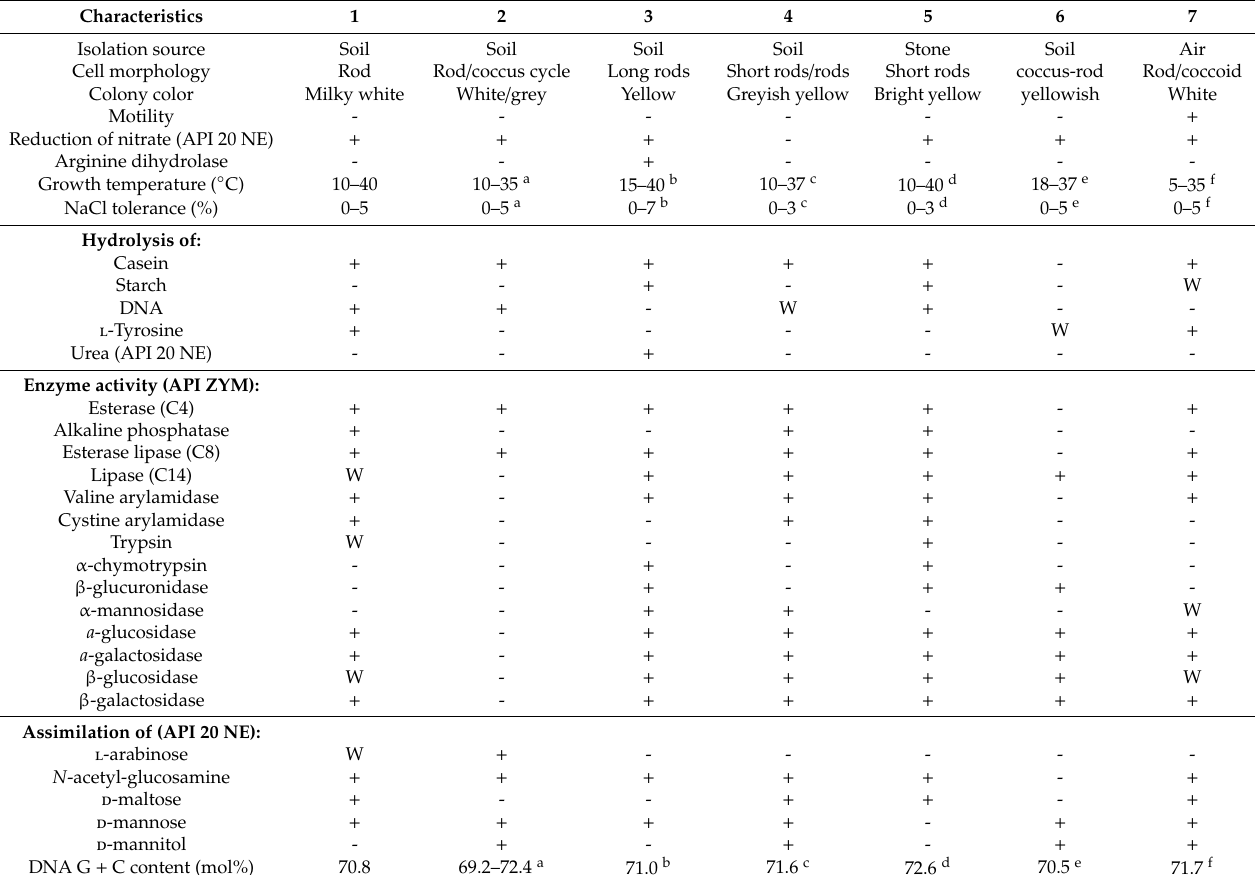
Table 1. Di ff erential characteristics of Terrabacter humi MAHUQ-38 T and phylogenetically closely related Terrabacter species. Strains: 1, T. humi MAHUQ-38 T ; 2, T. tumescens KACC 20535 T ; 3, T. terrae KACC 11642 T ; 4, T. terrigena KCTC 19602 T ; 5, T. lapilli LR-26 T ; 6, T. ginsengihumi KACC 19444 T and 7, T. aerolatus KACC 20556 T